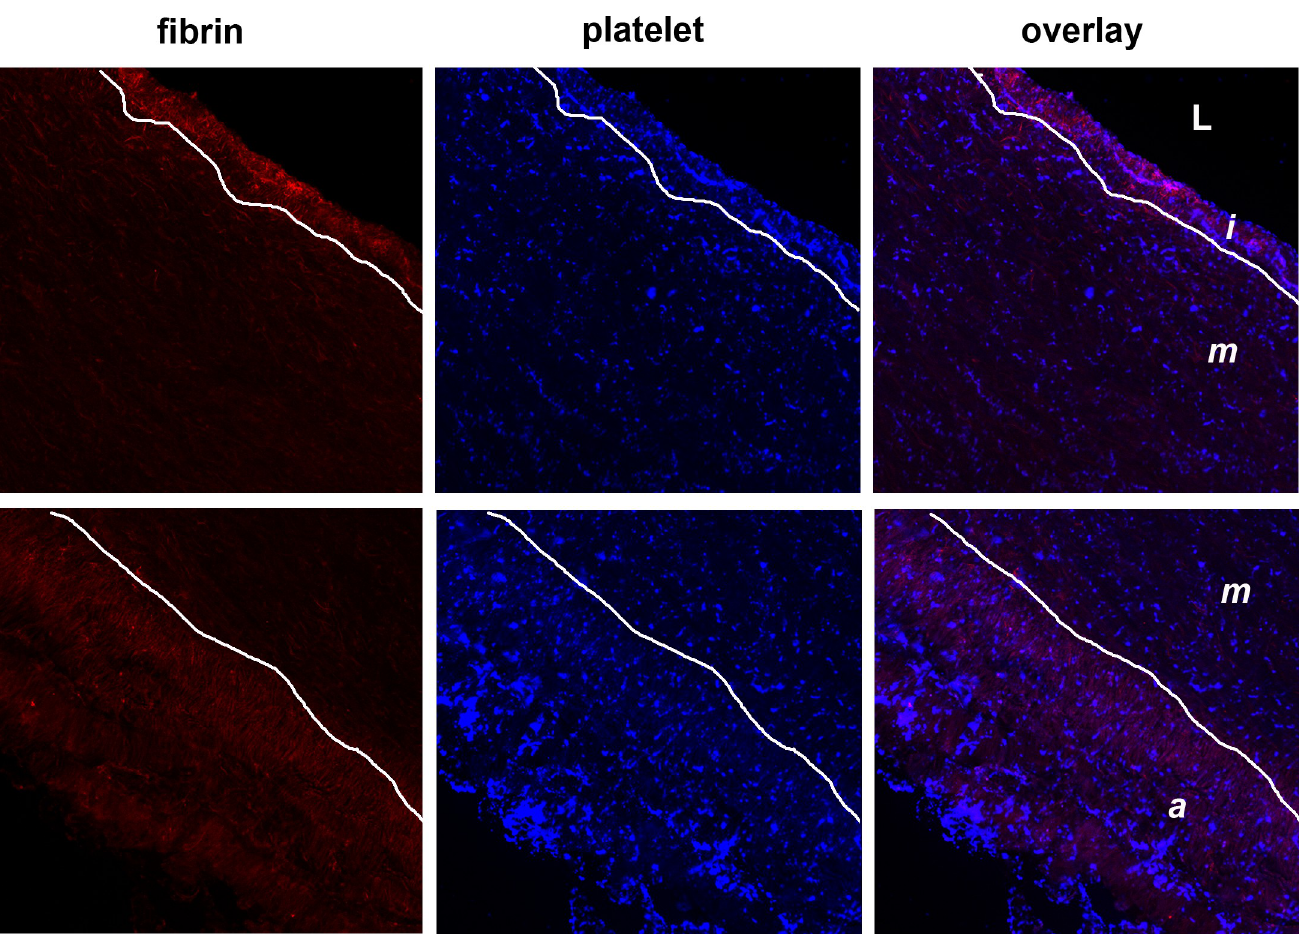
Fig 3. Platelet and fibrin deposition to arterial cross-sections detected by indirect immunofluorescence. Cryosections of allograft samples were perfused with heparinized whole blood and deposited platelets and fibrin were visualized with double immunofluorescence as detailed in Materials and Methods. Representative images illustrate the uneven spatial distribution of GpIIb/IIIa (blue) and fibrin (red) staining in the three layers of the perfused arterial cross-sections. For quantitative evaluation platelet and fibrin surface coverage data were collected from 5–10 such images (original size of the presented images 850 μ m × 850 μ m) to survey the whole size of the perfused cross-section, and the intrinsic green autofluorescence of elastin (Fig 4, here indicated by the white lines) was used as a guide to encircle the regions of interest and evaluate the three vessel wall layers separately. l: lumen; i: intima; m: media; a: adventitia.